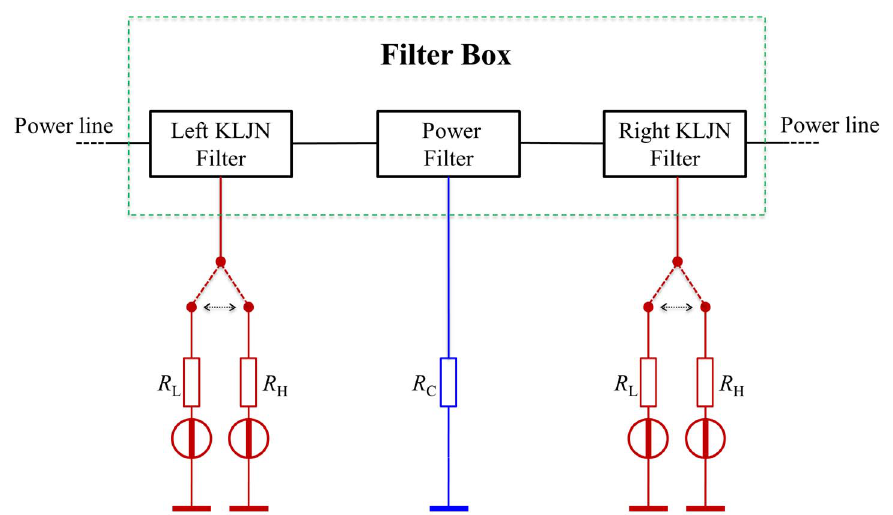
Figure 3. Building blocks in a filter box.